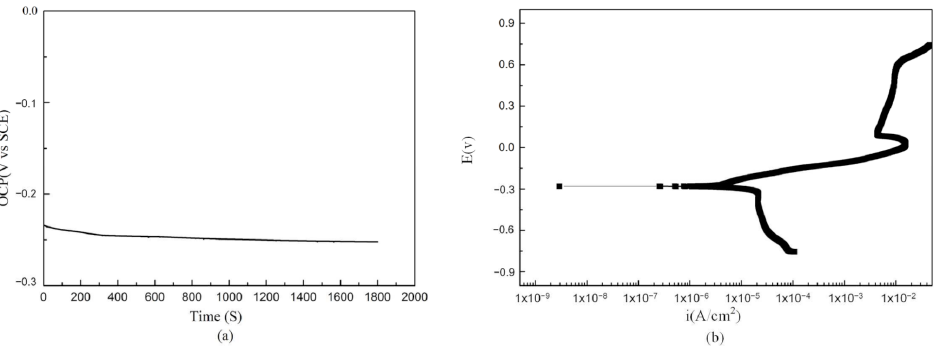
Figure 8. ( a ) Stable open circuit potential of NAB deposited by LENS in 3.5% NaCl. ( b ) Dynamic polarization curve of electrochemical corrosion of